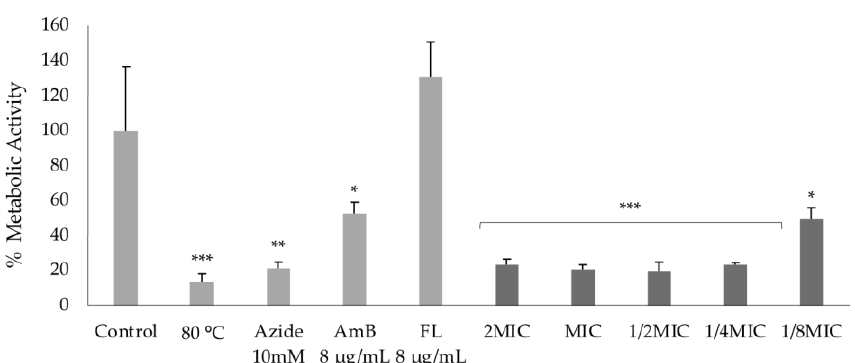
Figure 5. Metabolic activity of Candida albicans ATCC 10231 cells treated with different concentrations of compound 1 , three h after exposure. Data are shown as mean ± standard deviation of three independent assays. Controls included untreated cells incubated for 20 min at 80 ◦ C, 10 mM sodium azide, amphotericin B (AmB), and fluconazole (FL) at 8 µ g/mL. MIC: Minimal inhibitory concentration. * p < 0.05, ** p < 0.01, *** p < 0.001 (one-way ANOVA followed by Dunnett´s test).